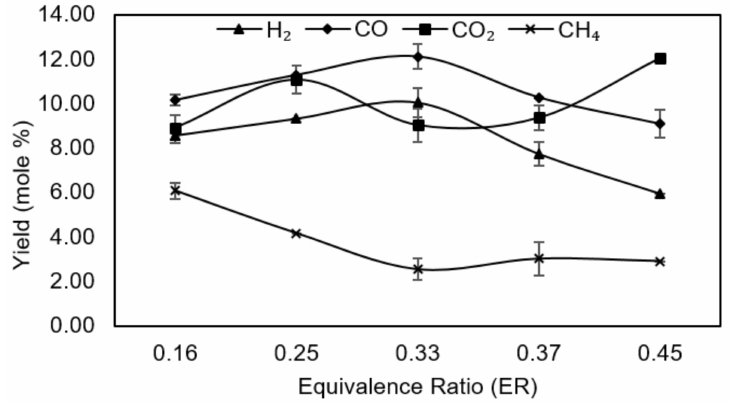
Figure 6. The e ff ect of equivalence ratio (ER) on syngas